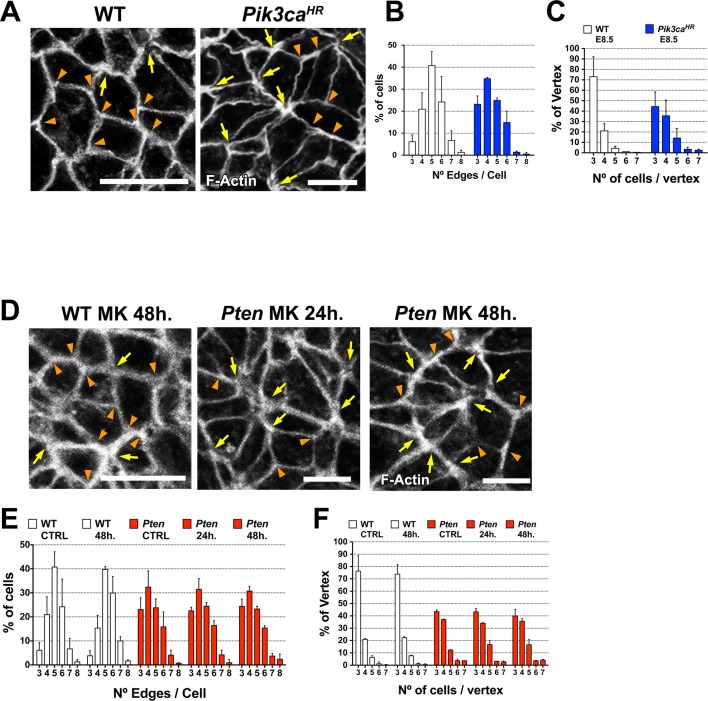
Cell packing in the neural plate with constitutively active PI3 kinase and when AKT is inhibited with MK-2206.(A) and (D) show high magnification views of the apical surface of the neural plate, with magnification adjusted so that the cells appear to be approximately the same size to highlight the difference in cell packing in the two genotypes. Scale bars in (A) and (D) = 15 μm. Orange arrowheads indicate examples of 3 cells/vertex, and yellow arrows indicate vertices formed by ≥4 cells. Cell borders marked by F-actin expression. (A) At E8.5, more rosette-like structures are seen Pik3caH1047R-Epi than in WT. (B) Quantification of percentage of cells with 3–8 edges (neighbors). As in E8.5 Pten △Epi mutants, the E8.5 Pik3caH1047R-Epi neural plate had ∼two fold more cells with 3 and 4 edges, and ∼55% fewer cells with 5 and 6 edges than WT. (C) There were ∼45% fewer vertices formed by 3 cells (the honeycomb arrangement) and ∼two fold increase in the number vertices formed by ≥4 cells in the E8.5 Pik3caH1047R-Epi neural plate compared to WT. (D–F) MK-2206 treatment does not affect distribution of cells with 3–8 edges or the percentage of vertices in any category. Bars indicate %, lines indicate s.d.